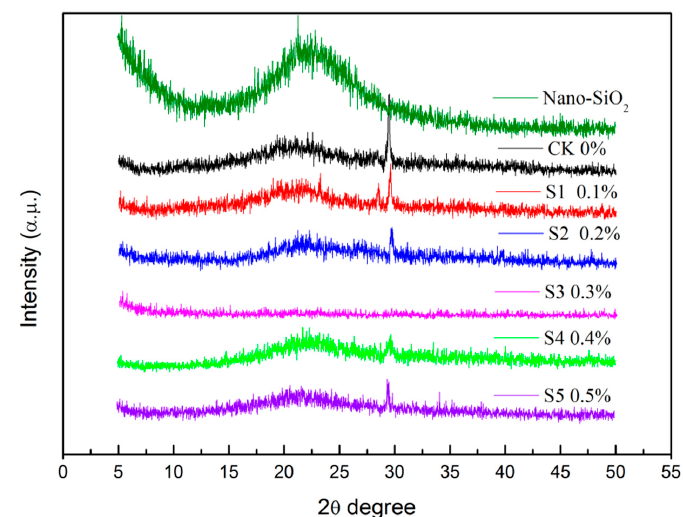
Figure 3. X-ray diffraction (XRD) of konjac glucomannan (KGM)/ carrageenan (KC)/nano-silica films and KGM/KC films (CK: 0% nano-silica; S1: 0.1% nano-silica; S2: 0.2% nano-silica; S3: 0.3% nano-silica; S4: 0.4% nano-silica; S5: 0.5% nano-silica).